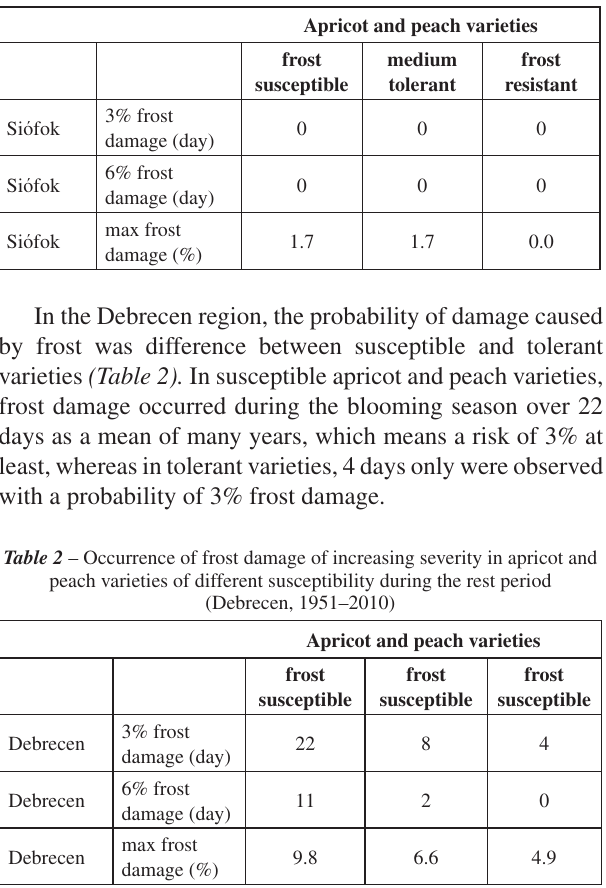
Table 1 – Occurrence of frost damage of increasing severity in apricot and peach varieties of different susceptibility during the rest period (Siófok, 1951–2010)